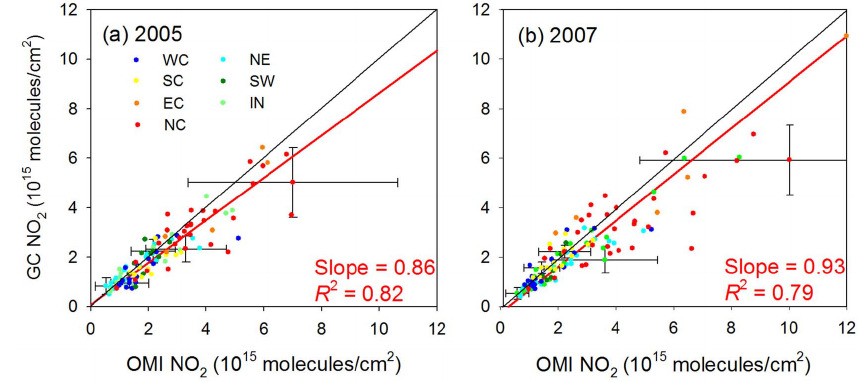
Fig. 3. Comparisons between GEOS-Chem and OMI summer average tropospheric NO 2 columns for (a) 2005 and (b) 2007 over power plant dominant grids in China. Grids are colored by the regions defined in Fig. 2. The linear fit regression (red line) is based on Reduced Major Axis (RMA) algorithm (Clarke, 1980). Error bars indicate the standard deviations in the summer average columns (only shown for minimum, quartiles, and maximum points in OMI